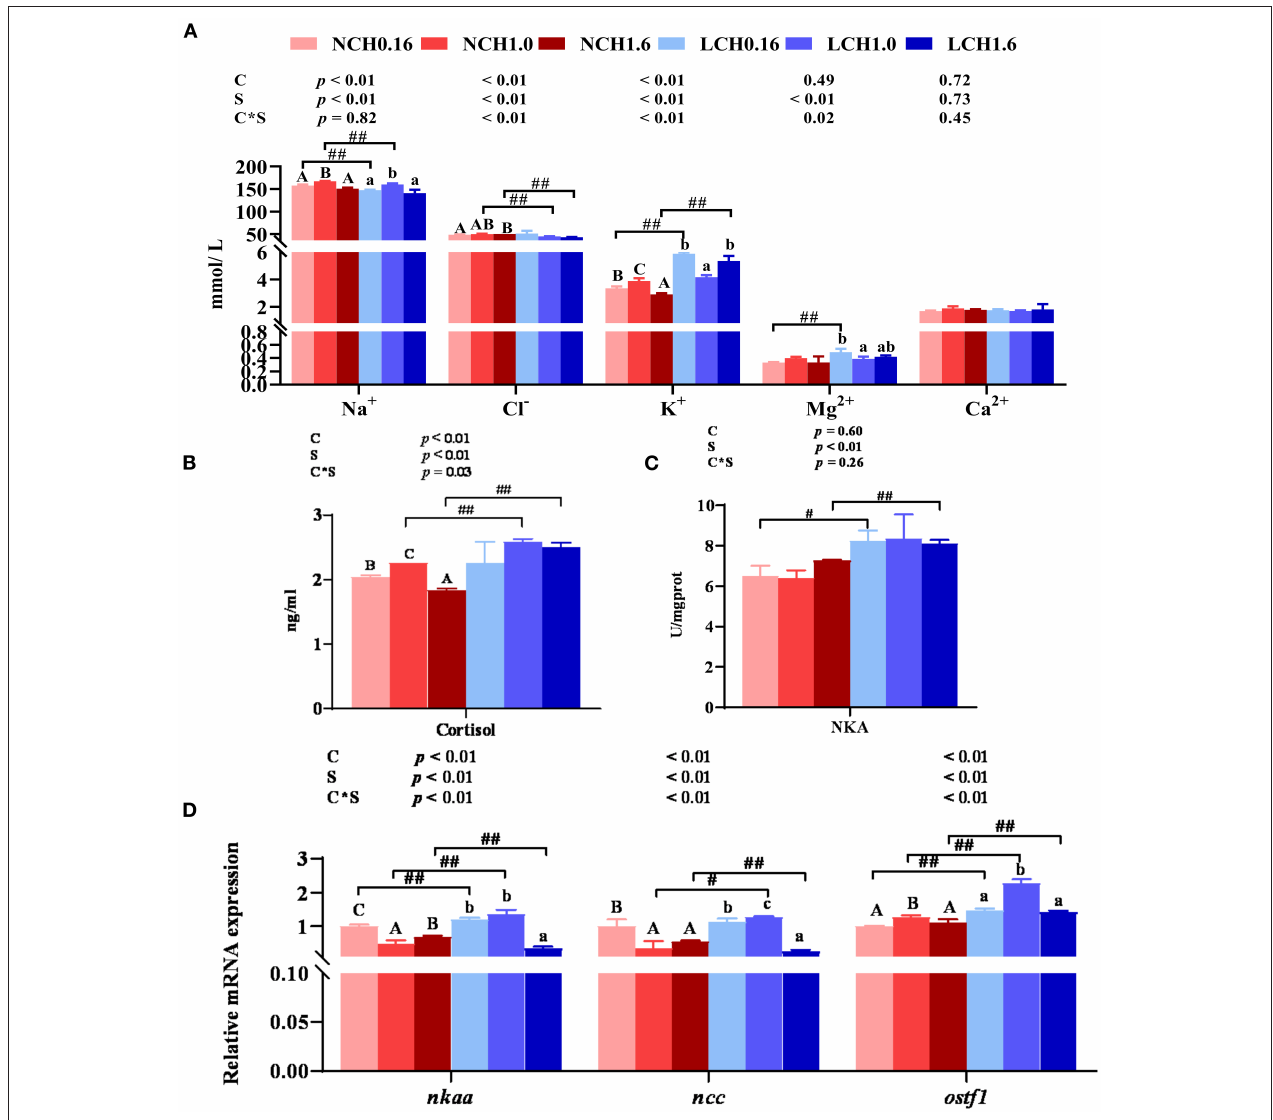
FIGURE 1 | Effects of dietary cholesterol level and water salinity on osmoregulation ability of juvenile black seabream ( Acanthopagrus schlegelii ). Concentrations of ions inserum (A) , cortisol concentrations inserum (B) , Na + / K + -ATPase activitiesin gill (C) , andrelative gene expression levels involved in osmoregulation in gill (D) . The group of NCH 0.16 was set as the reference group, and the mRNA expression levels of target genes were normalized relative to the expression of β -actin . Values are presented as the means ( n = 3), with standard errors represented by vertical bars. Two-way ANOVA P -values are shown in each panel, with “C” representing effects of dietary cholesterol levels, “S” representing effects of salinity, and “C*S” representing interaction between dietary cholesterol levels and salinity. “ABC” representing significant ( P < 0.05) difference between dietary cholesterol levels in normal water salinity (23 psu) and “abc” representing significant ( P < 0.05) difference between dietary cholesterol levels in low water salinity (5 psu) by performing one-way ANOVA. “#” representing significant ( P < 0.05) difference between water salinity with same dietary cholesterol level and “##” representing highly significant ( P < 0.01) difference between water salinity with same dietary cholesterol level by performing t -test. Ca 2 + , calcium; Mg 2 + , magnesium; Na + , sodium, Cl − , chlorine; K + , potassium; ostf1 , osmotic stress transcription factor 1; ncc , Na + -Cl